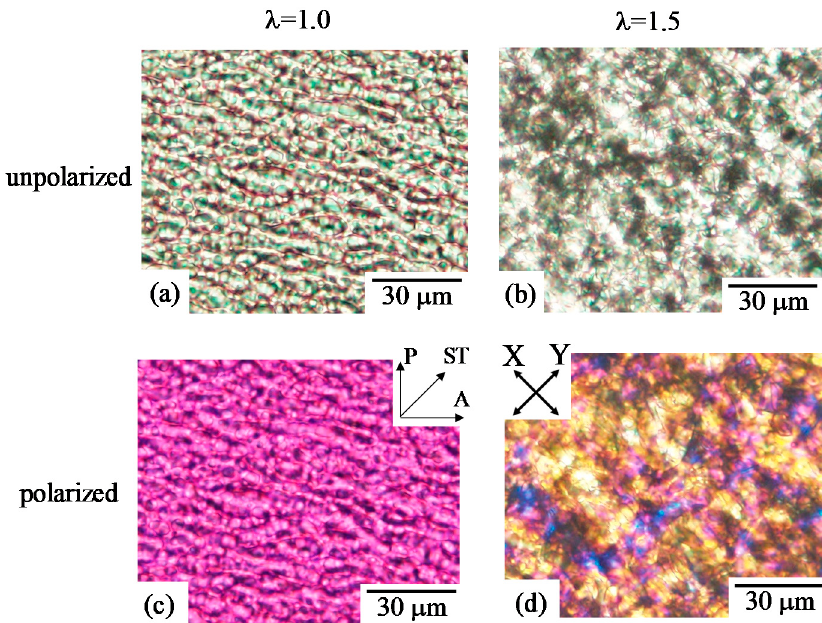
Figure 3. Unpolarized and polarized optical micrographs of 50/50 PC/PMMA obtained by simultaneous biaxial stretching at draw ratios λ of 1.0 and 1.5. ( a ) λ = 1.0 (unpolarized); ( b ) λ = 1.5 (unpolarized); ( c ) λ = 1.0 (polarized); ( d ) λ = 1.5 (polarized).